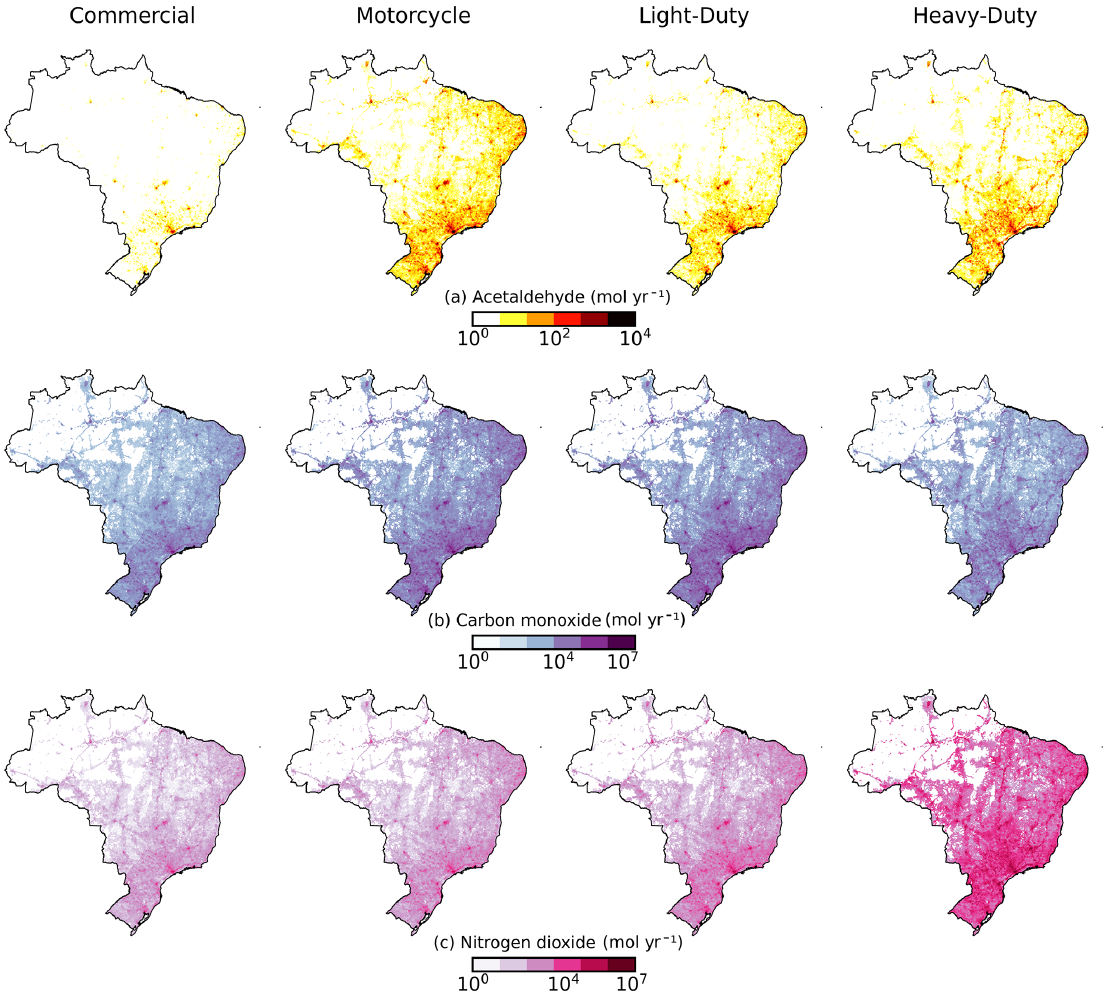
Figure 3. Vehicular emissions of (a) acetaldehyde, (b) carbon monoxide, and (c) nitrogen dioxide from commercial light vehicles, motorcy- cles, light-, and heavy-duty vehicles in